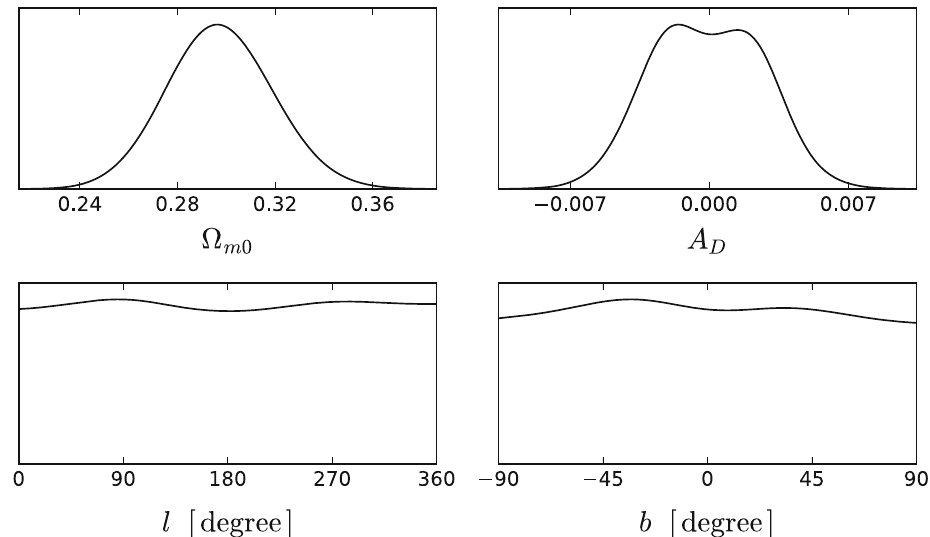
Fig. 3 The marginalized probability distributions of (cid:8) m 0 , the dipole magnitude A D , and the dipole direction ( l , b ) , obtained by using the DF method to the Pantheon data. See the text for